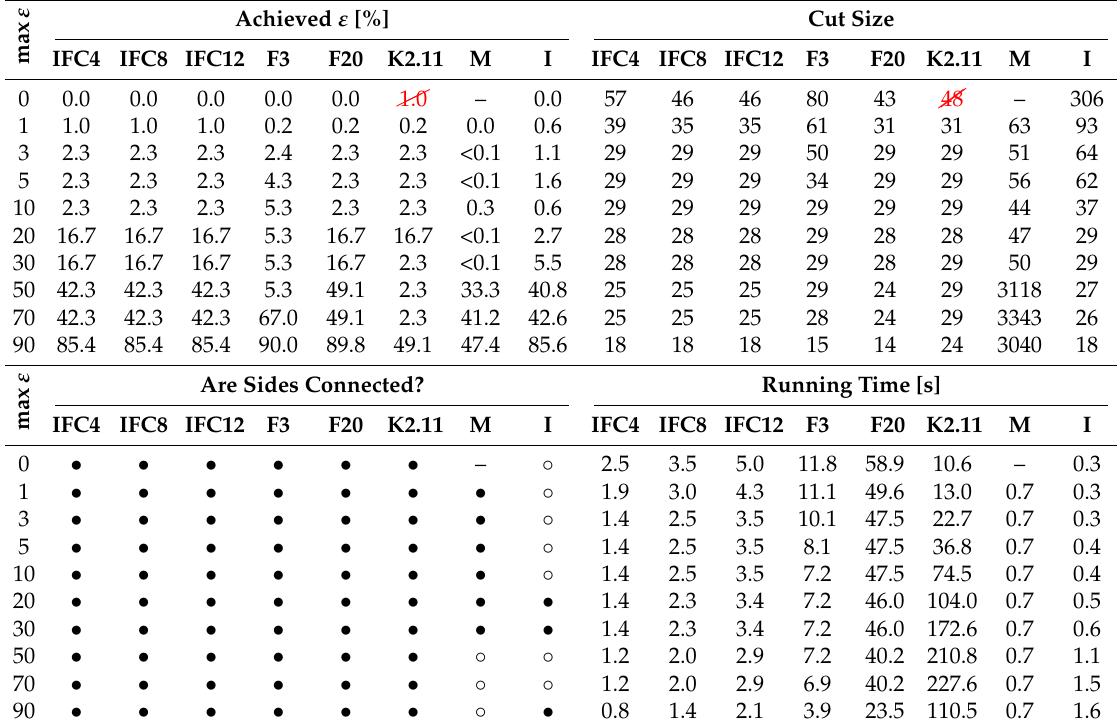
Table 5. Pareto cuts of California and Nevada.